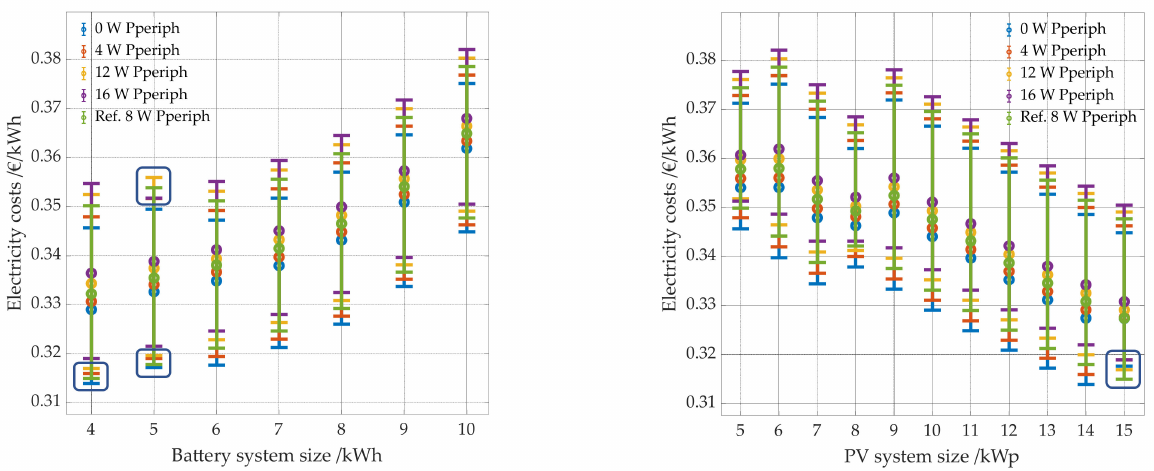
Figure 22. Electricity costs per kWh as a function of battery system size ( left panel) and PV system size ( right panel). The results for different levels of peripheral consumption are shown in color. The reference case with a peripheral consumption of 8 W is shown in